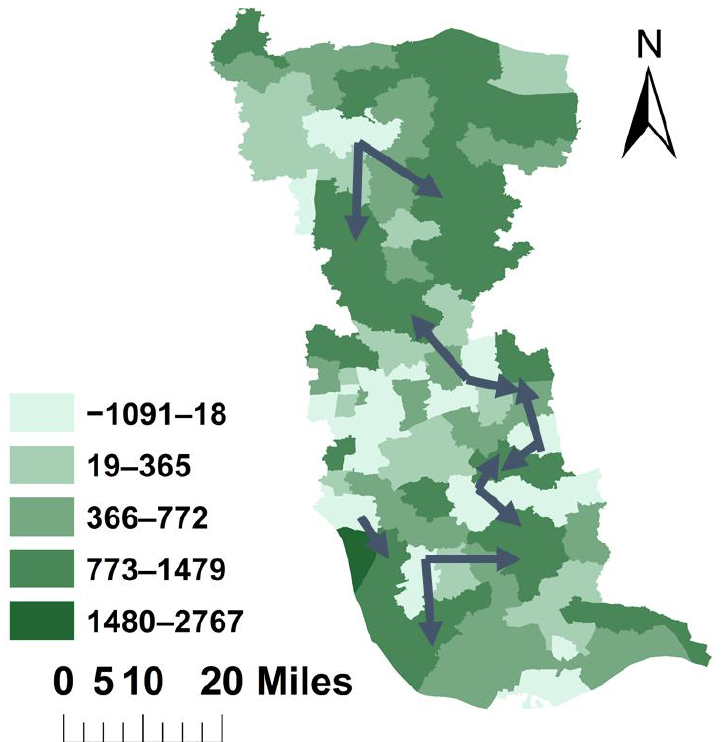
Figure 8. Nitrogen demand potential (t/a) for arable land based on pollution load (arrows point to livestock nutrient transfer scenarios for the township).